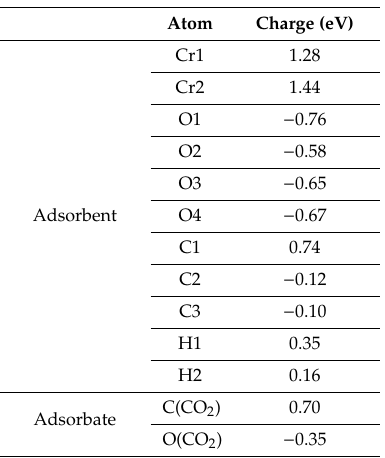
Table 4. The charges of adsorbents and